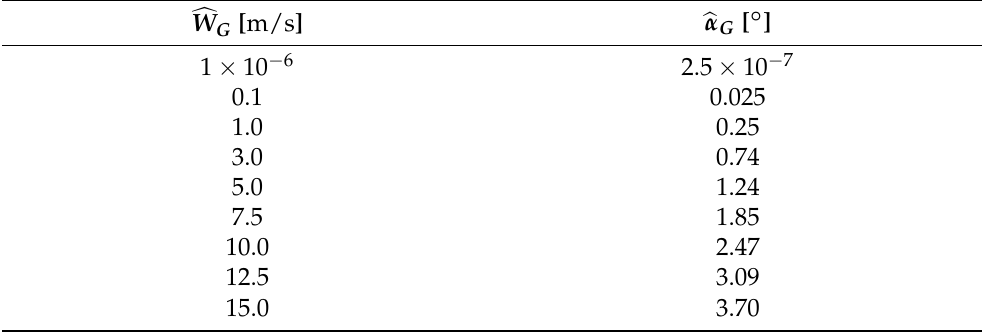
Table 3. Gust velocities and gust-induced angles of attack at Mach 0.70, using (cid:98) α G = arctan ( (cid:98) W G / U ∞ )